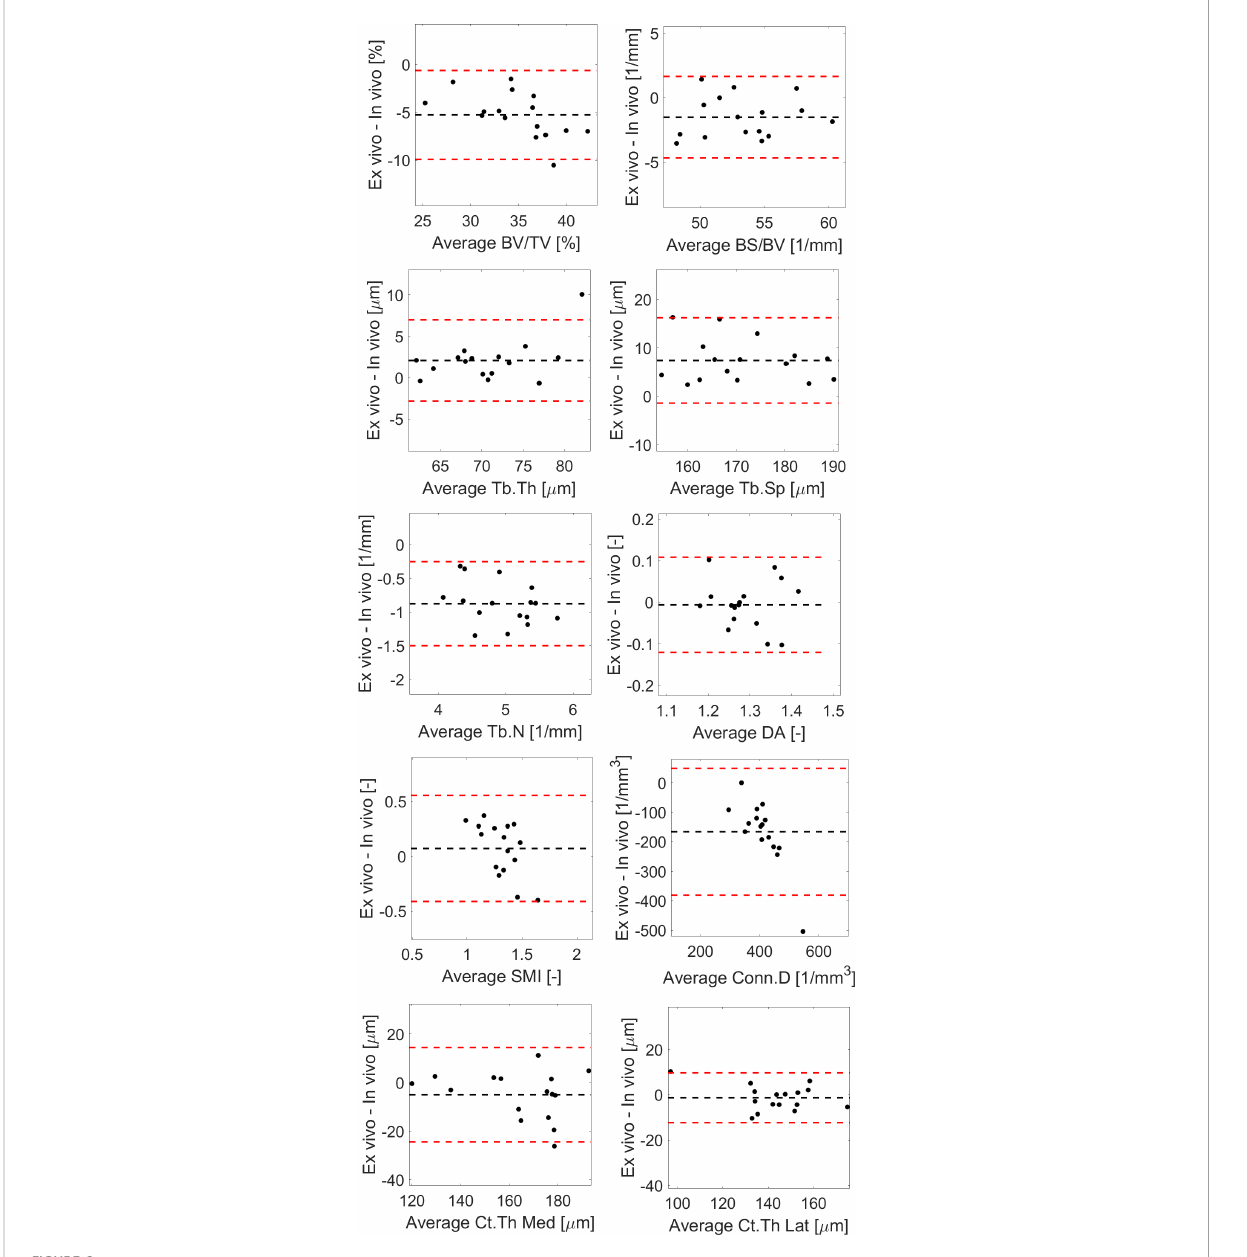
FIGURE 6 Bland-Altman plots between in vivo and ex vivo measurements for trabecular bone volume fraction (BV/TV), bone surface fraction (BS/BV), trabecular thickness (Tb.Th), separation (Tb.Sp), number (Tb.N) and degree of anisotropy (DA), structure model index (SMI), connectivity density (Conn.D), and cortical thickness (Ct.Th) in the medial or lateral